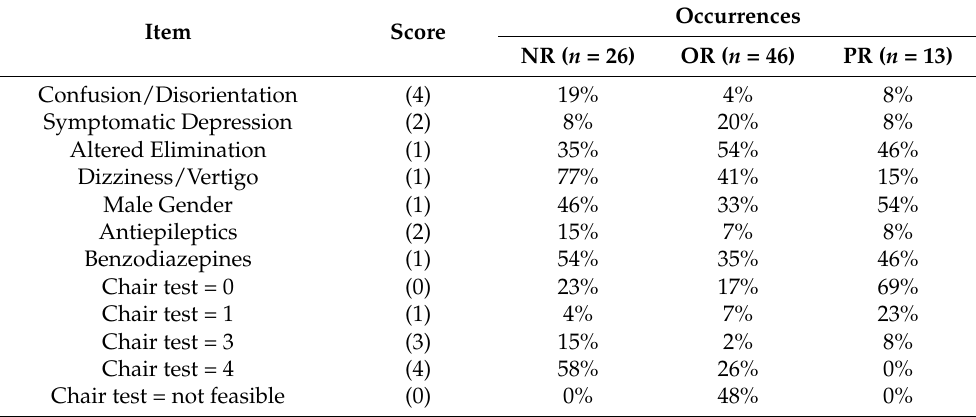
Table 2. Occurrences of the HIIFRM (Hendrich Fall Risk Model II) items in subjects at discharge from NR (neurological rehabilitation), OR (orthopedic rehabilitation) and PR (pulmonary